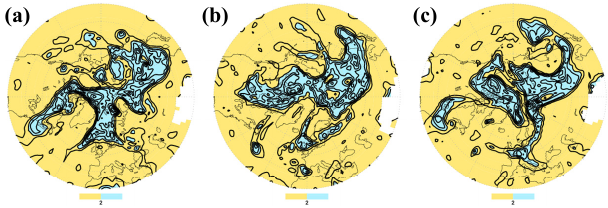
Figure 11: Potential Vorticity (PVU, color shading) on 300 K potential temperature level. 3 Fig. 11. Potential Vorticity (PVU, color shading) on 300K poten- tial temperature level. Yellow: PV less 2PVU (tropospheric air), Yellow: PV less 2 PVU (tropospheric air), blue: PV larger 2 PVU (stratospheric air). (a): 30 4 blue: PV larger 2PVU (stratospheric air). (a) 30 December 2009; December 2009; (b) 1 January 2010, (c) 3 January 2010. 5